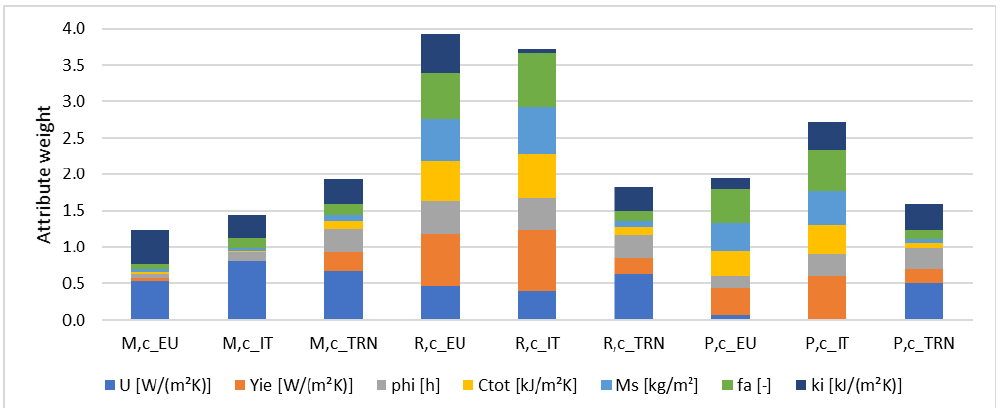
Figure 15. Weight analysis of the thermo-physical attributes of opaque structures, for the summer period and with g gl,n = 0.34.